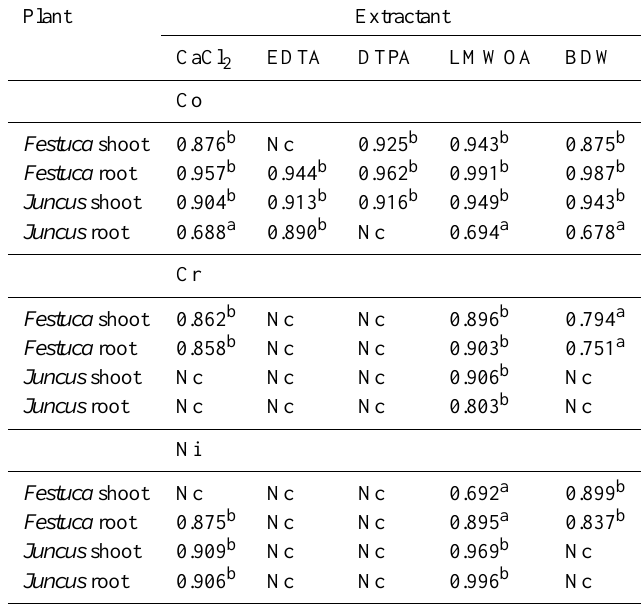
Table 5. Pearson’s correlation between extracted Co, Cr and Ni and its content in plants.